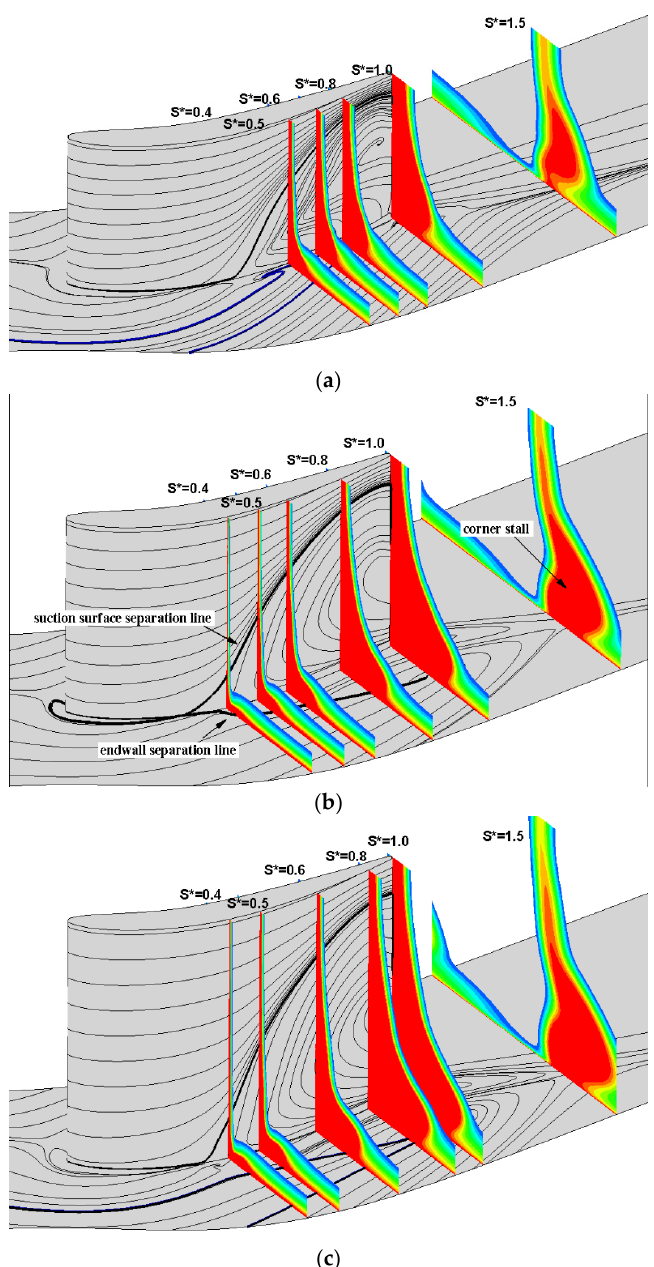
Figure 10. Influence of aspect ratio on limiting streamlines and the passage total pressure loss coefficient at the i = 3 ◦ incidence angle: ( a ) origin, h / c = 1; ( b ) origin, h / c = 1.32; and ( c ) origin, h / c =